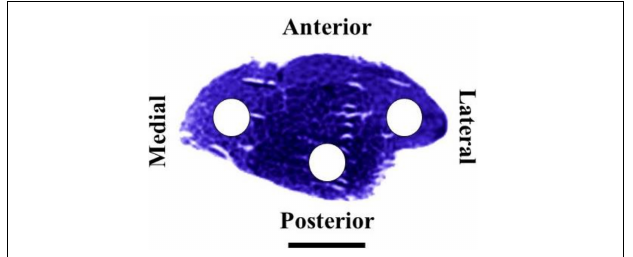
FIGURE 1 | Equatorial transverse section of the right rat tibialis anterior muscle stained for succinate dehydrogenase. Circles indicate lateral, medial and posterior zones selected for histochemical and morphometrical analyses. Scale bar, 5